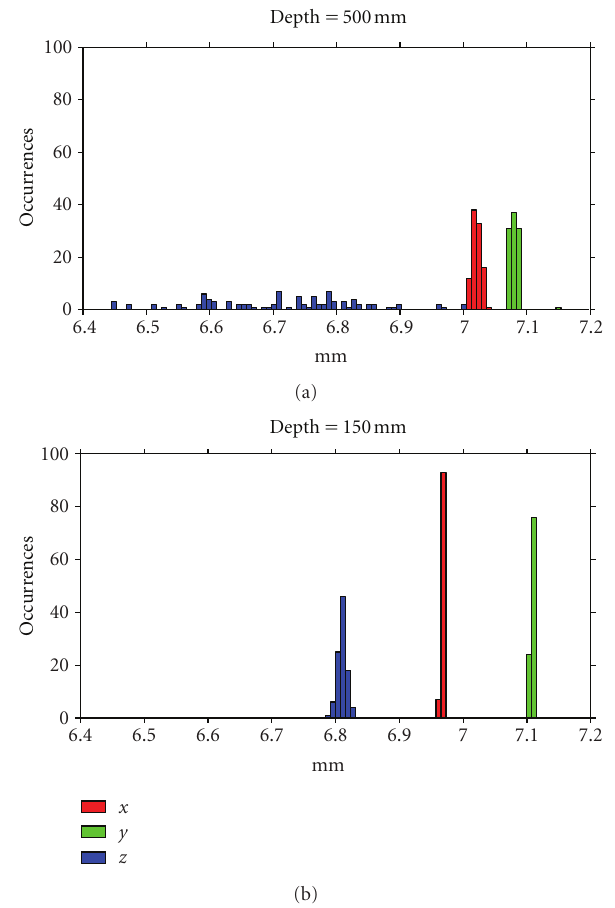
Figure 3: Distribution of displacement experimental data; (a) distance camera-target (cid:2) 500 mm; (b) distance camera-target (cid:2) 150 mm.